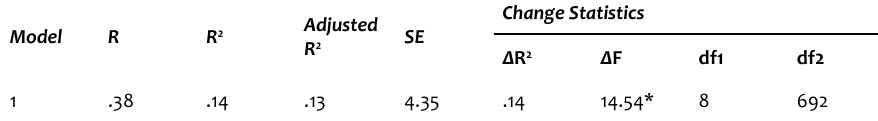
Table 4. Model Summary Table of MLR Analysis